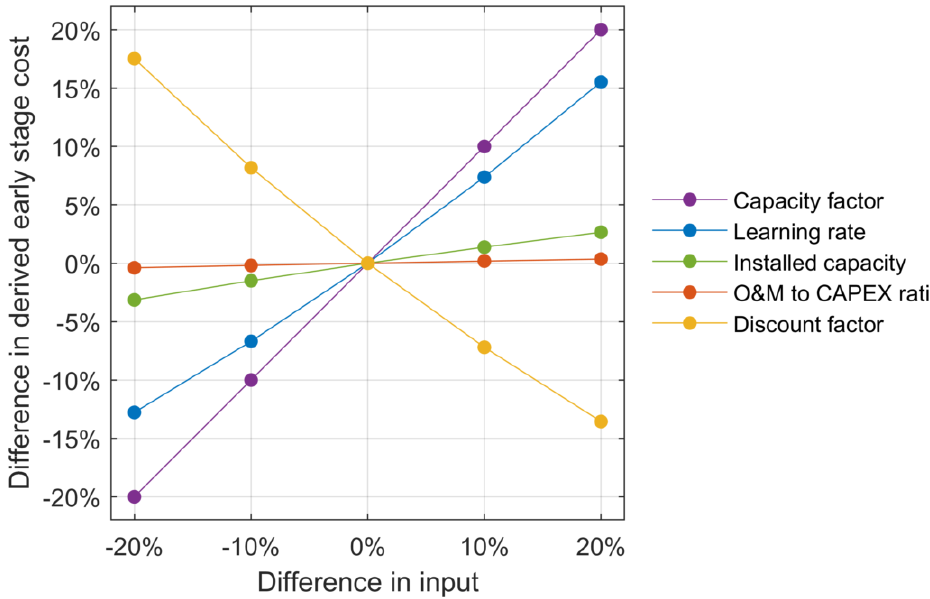
Figure 9. Sensitivity analysis on floating offshore wind results, based on central LR scenario.